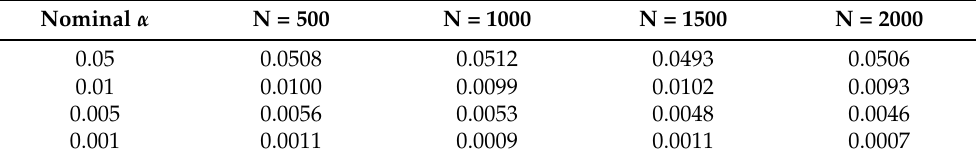
Table A1. Type I error simulation using cGFLM for binary outcomes based on the CHRNA7 gene.